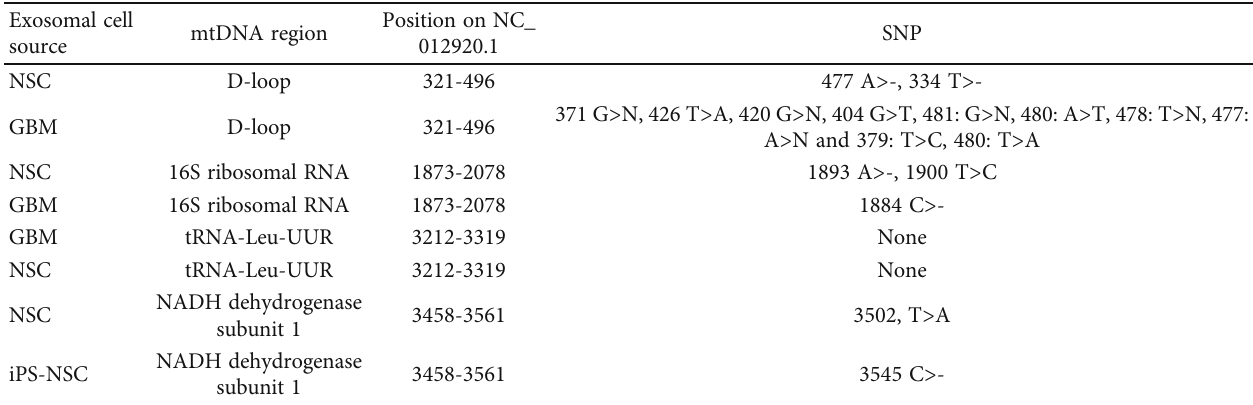
Table 2: A concise account of the SNP found in exosomal mtDNA. D-loop region 321-496 in GBM has a signi fi cantly higher occurrence of SNP over other regions and cell lines. Except for one SNP found at position 3545 (C > -) in NADH dehydrogenase subunit 1 region 3458- 3561, the rest of the iPS-NSC and iPS-NSC-AD cell line clones had 100% identity to the reported sequences in the human mitochondrial genome (NC_012920.1) for all other genes. Each SNP in a clone is unique irrespective of the primer pair or a cell